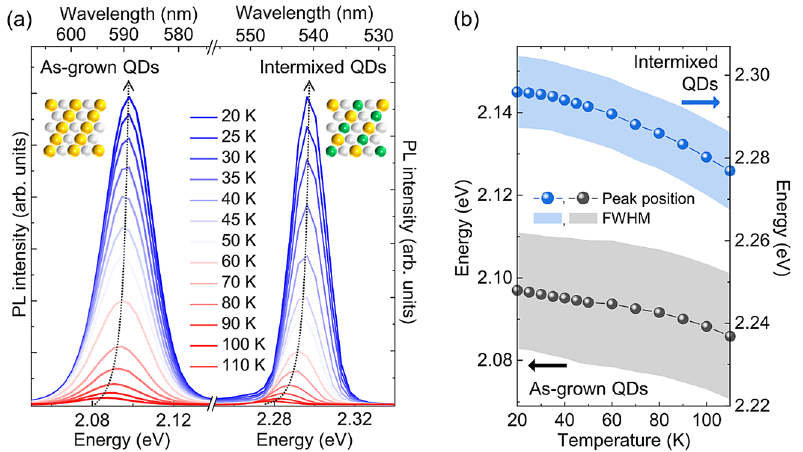
Figure3: (a)Temperature-dependentPLspectraoftheas-grownCdTeQDsandintermixedCd x Zn 1 − x TeQDs( t Anneal =120s).(b)Plotsofthederived emission peak and linewidth change (from Figure 3a) with respect to the measurement temperature. QD, quantum dot; PL,